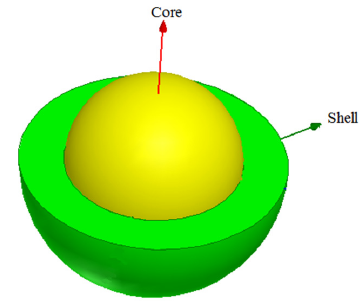
Figure 2. Schematic of core ‐ shell nanoparticles: core in the center (yellow part) and other material located around the central core (green part).